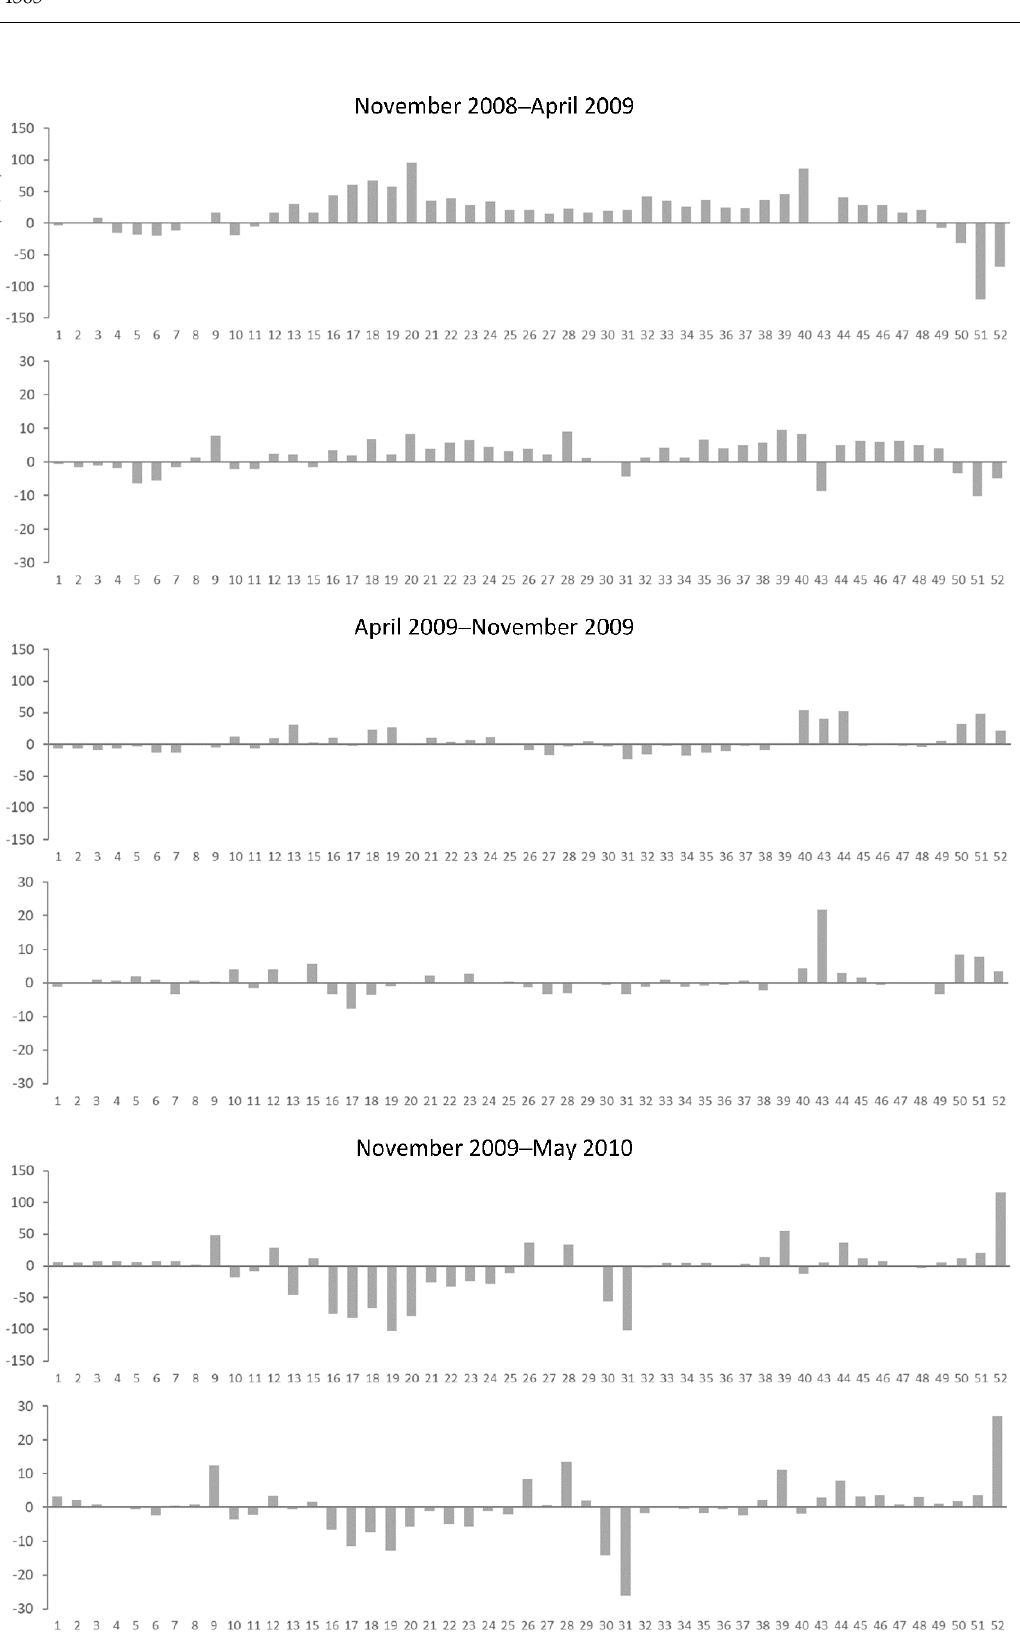
Figure 11. Seasonal changes in volume and shoreline position per segment, presented from north (segment 1) to south (segment 52); segment IDs are presented below the graphs; positive shoreline change values represent seaward migration and negative values represent landward migration.